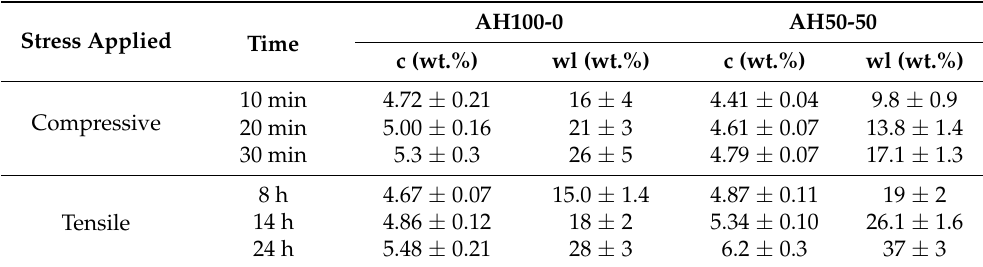
Table 1. Hydrogels mean alginate concentration (c) and water lost (wl) after the two SCDP carried out during different times. Alginate concentration before the SCDP was 4 wt.% (C4.0AH100-0 and C4.0AH50-50) in all cases, as been mentioned